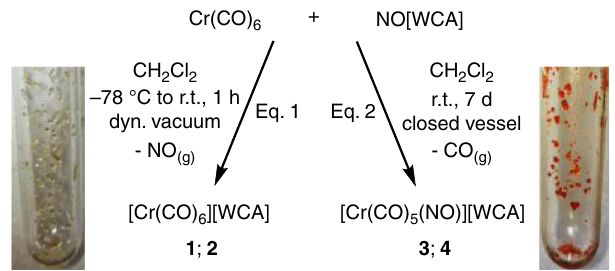
Fig. 1 Reaction scheme yielding complexes 1 and 2 (Eq. 1) as well as 3 and 4 (Eq. 2). The pictures show the crystalline complexes 1 (pale yellow) and